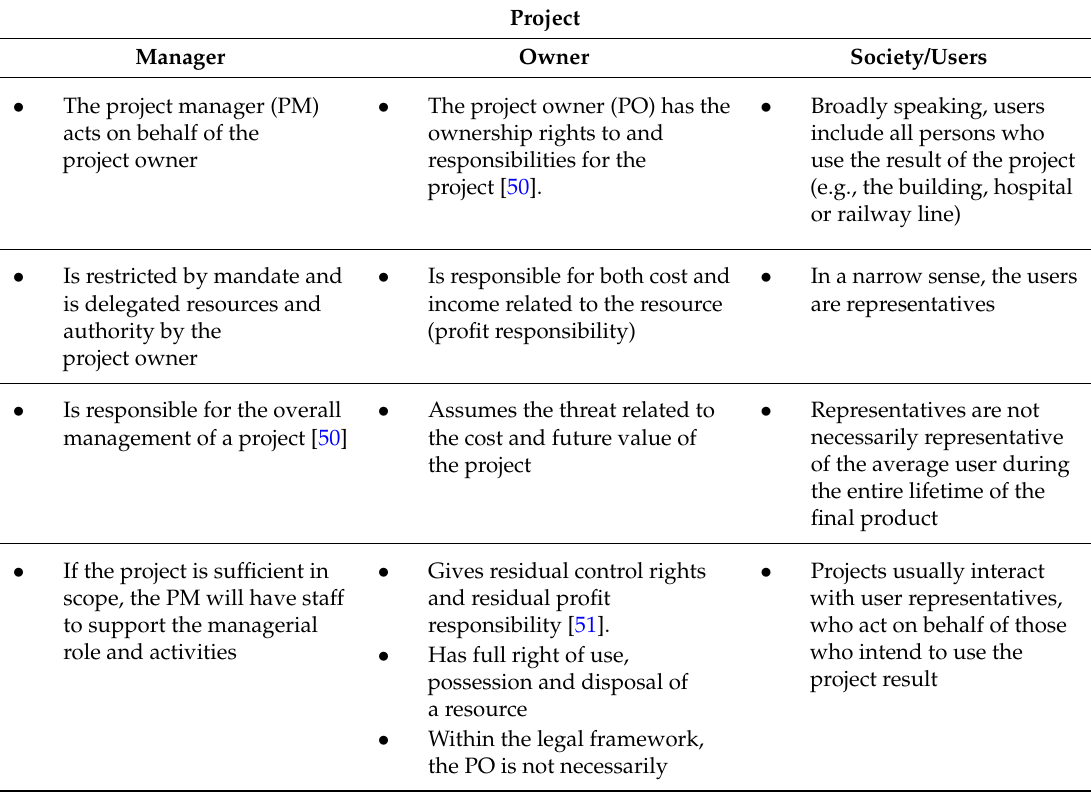
Table 3. Summary of the roles in a